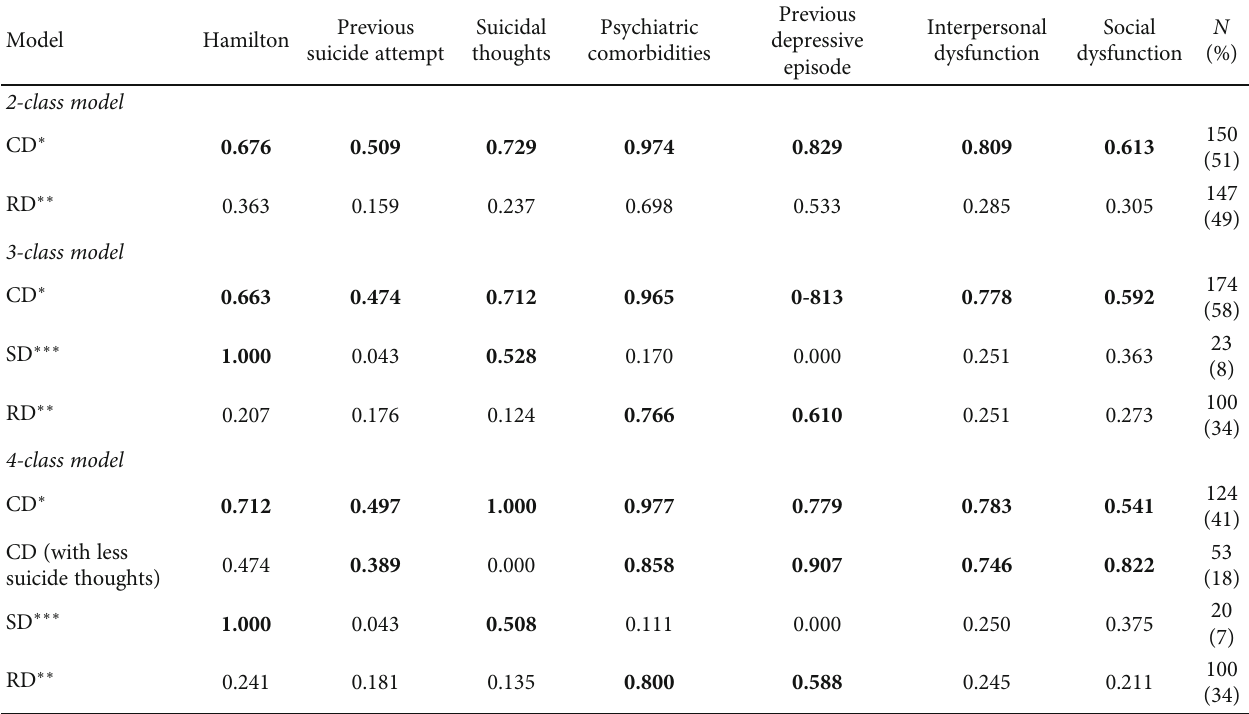
Table 3: Likelihood of each indicator according the two, three, and four-class models, in 297 patients in primary care in Chile.